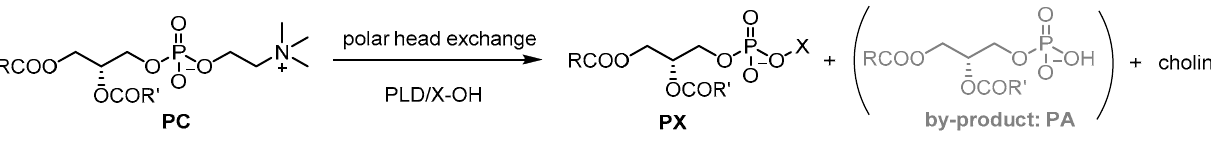
Figure 2. Phospholipase D-catalysed transformations of PC.